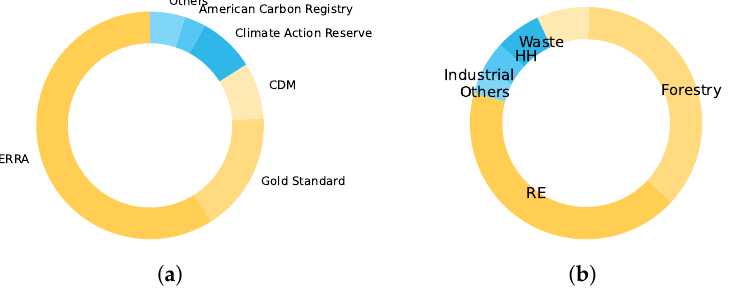
Figure 2. Market share of program standards and project types in 2019. Notes: Panel ( a ) shows the market share of carbon offset certification programs in 2019 based on traded carbon offsets. Panel ( b ) shows the market share of carbon offset project types in 2019 based on traded carbon